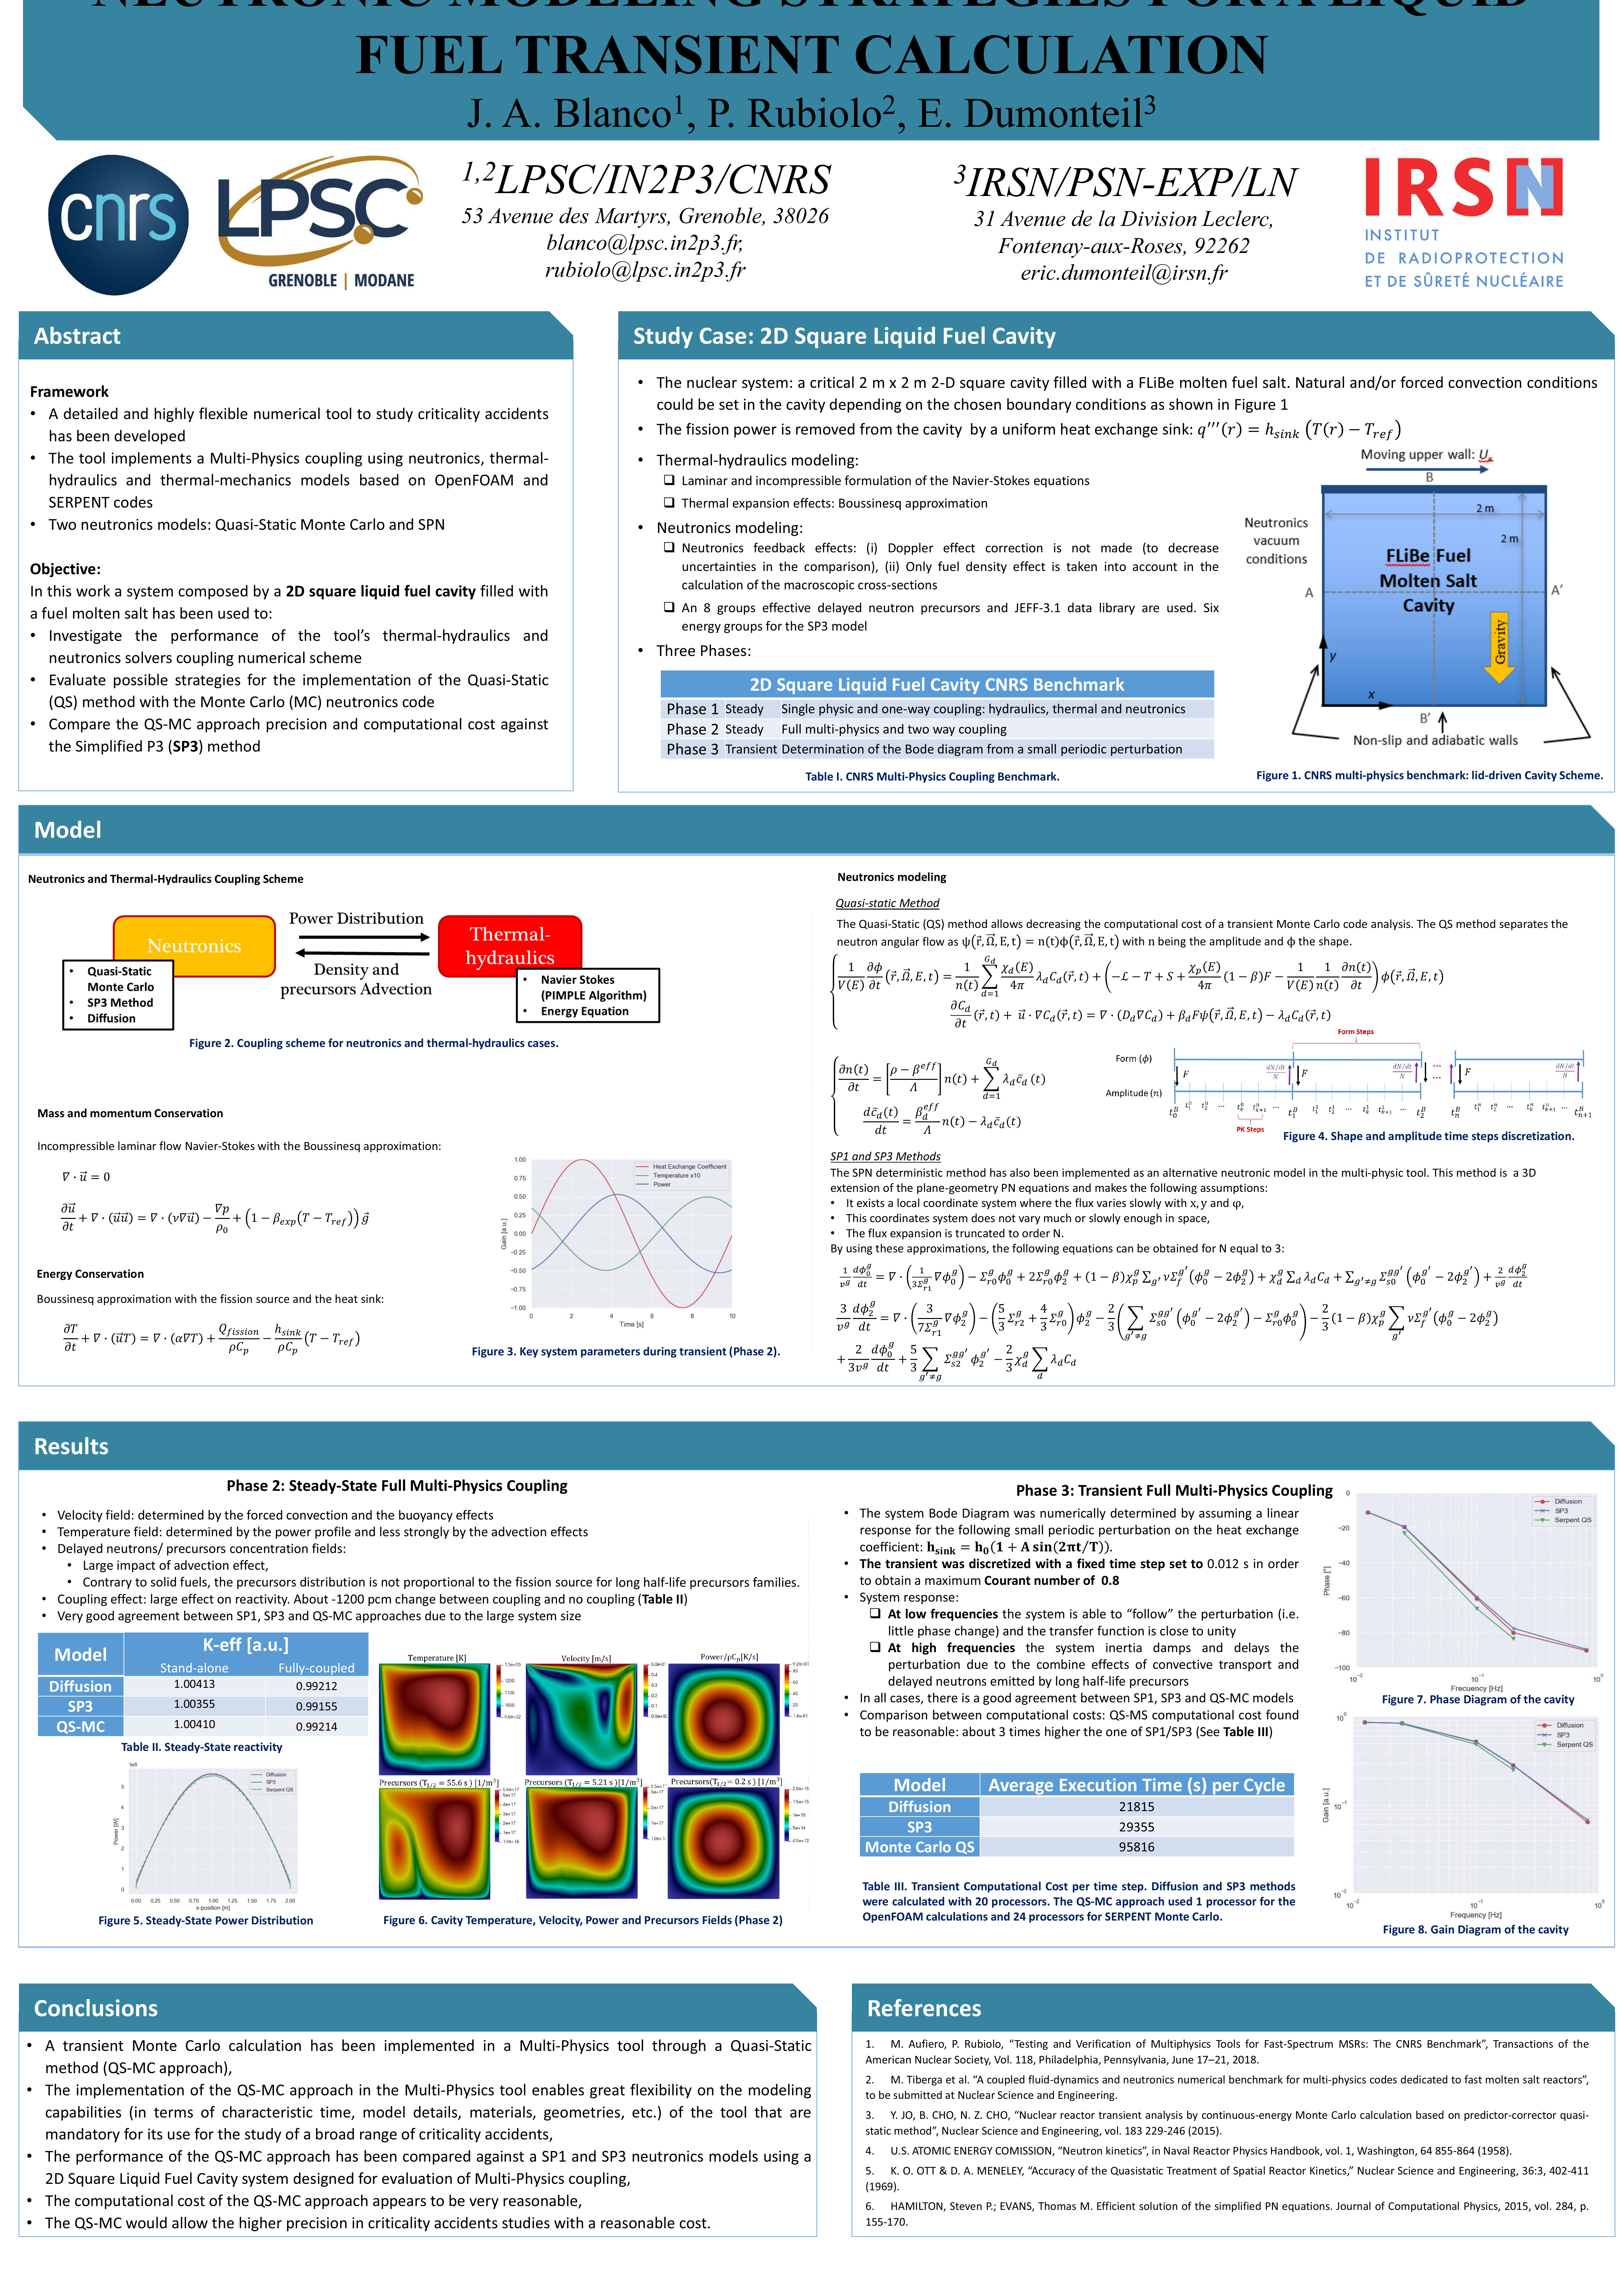
Figure 8. Gain Diagram of the